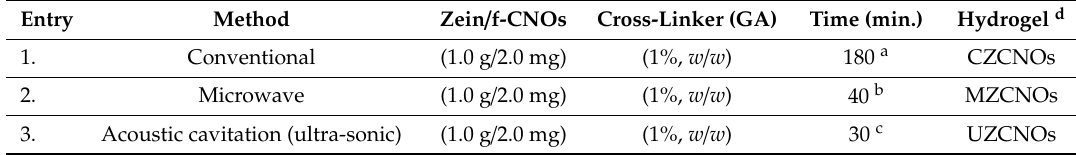
Table 1. Reaction conditions and fabrication methods of